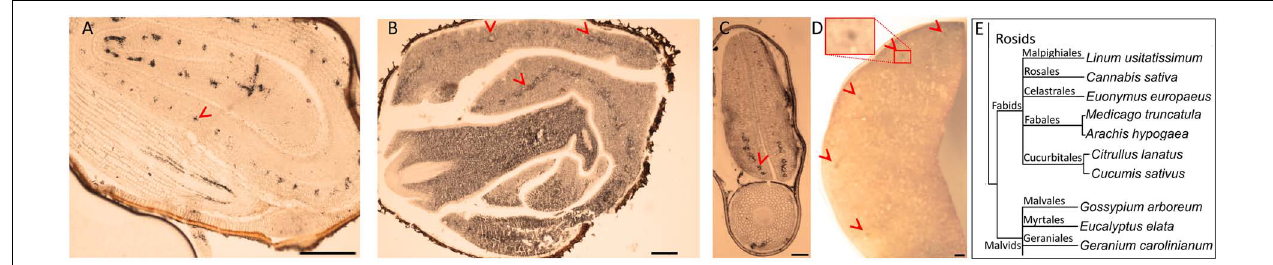
FIGURE 3 | Fe-enriched endodermis is conserved in distinct plant orders. Seed cross sections belonging to members of various orders were stained with Perls/DAB and observed under light microscope. From panels (A–C) , Gossypium arboreum . Eucalyptus elata and M. truncatula , respectively. (D) Single cotyledon of Arachis hypogaea . Fe staining appeared black in panels (A–C) and brown in panel (D) . Outer brown–black cover in panels (A–C) are seed coats. These were already brown before the staining, thus the color do not reflect the stained Fe. In panel (A) , longitudinal section of hypocotyl and cross section of folded cotyledons can be differentiated. Red arrow heads show Fe enrichment surrounding the provascular strands of cotyledons. (E) Branch of the taxonomic tree, for the whole tree refer to Figure 8 . This branch shows species that were examined for Fe reserves in distinct orders and used as a visual aid. Note that only selected examples from panel (E) is shown through (A–D) . Bar is 1 mm for panel (A) and 0.1 mm for panels (B–D) . Red arrow heads point to examples of specific Fe accumulation pattern, closed rings around provasculature of